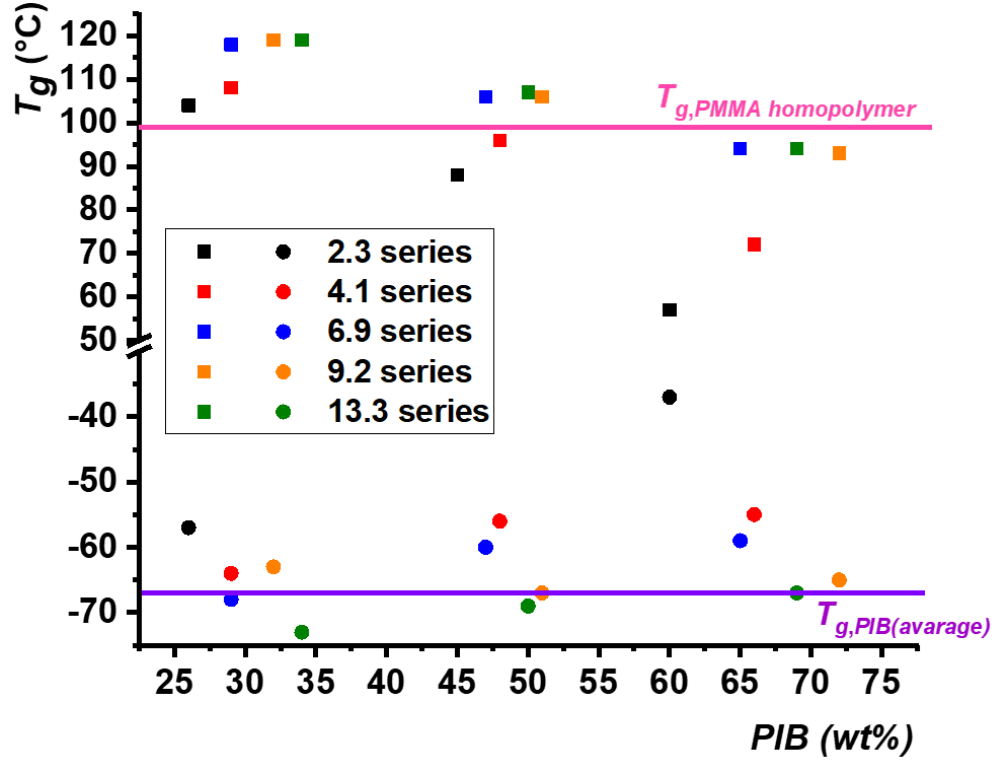
Figure 2. Glass transition temperatures ( T g ) of the PMMA- l -PIB conetworks as a function of composition (the lines represent the T g of the MA-PIB-MA macromolecular cross-linkers and the PMMA homopolymer).